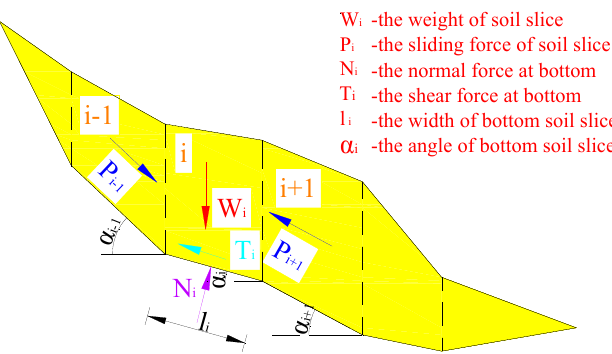
Figure 2. The calculation diagram of residual thrust method.